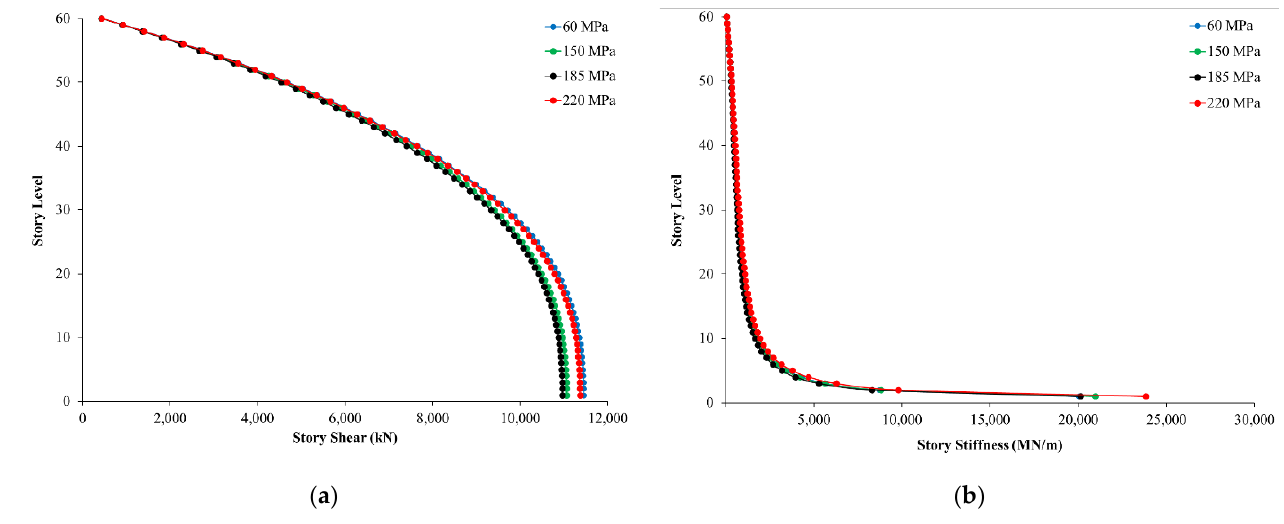
Figure 7. ( a ) Story shear; ( b ) story stiffness. Table 6. Spandrels design s ummary.